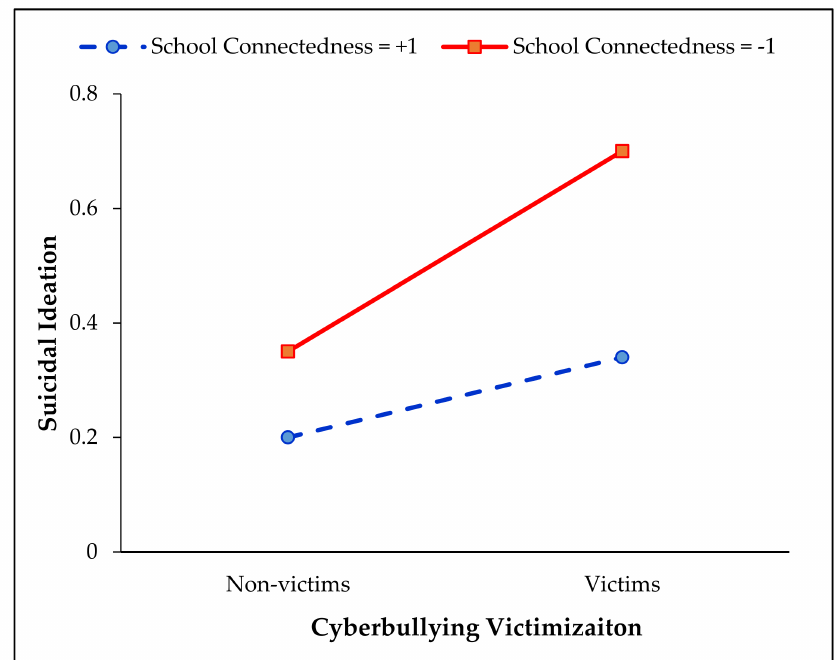
Figure 1. Moderating effect of school connectedness on the relationship between cyberbullying victimization and suicidal ideation. Simple slopes plot at low (–1 SD) and high (+1 SD) levels of school